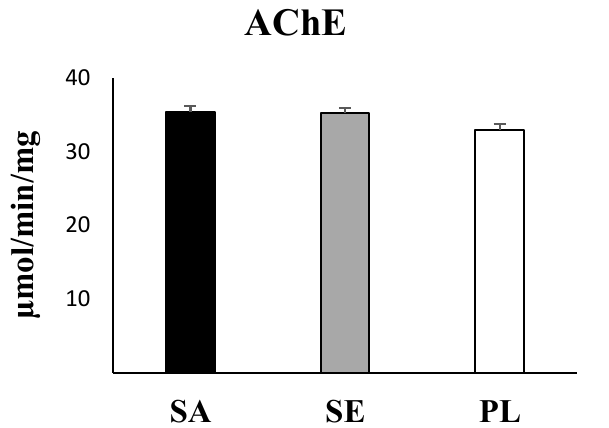
Figure 6. Acetylcholinesterase (AChE) activity in the digestive tract of H. tubulosa . No significant differences were observed. SA, Sant Antoni de Portmany; SE, Santa Eulària des Riu; PL, Pou des Lleó.